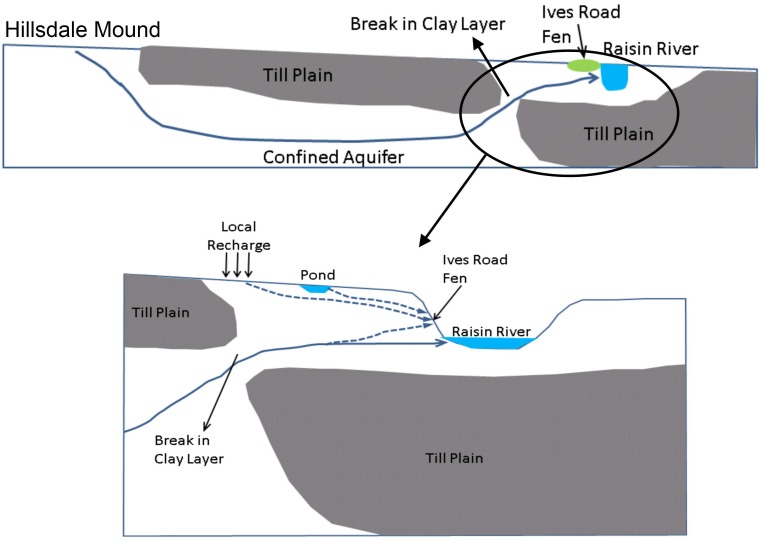
Conceptual model for Ives Road Fen.